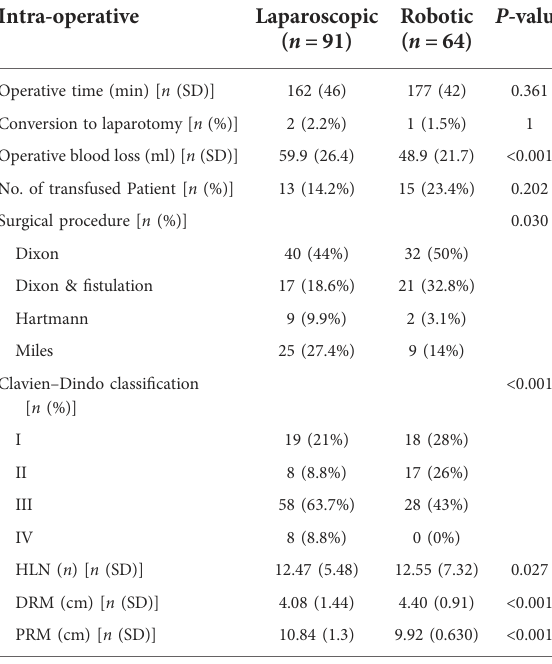
TABLE 2 Intra-operative and pathology data. TABLE 3 Postoperative outcome.